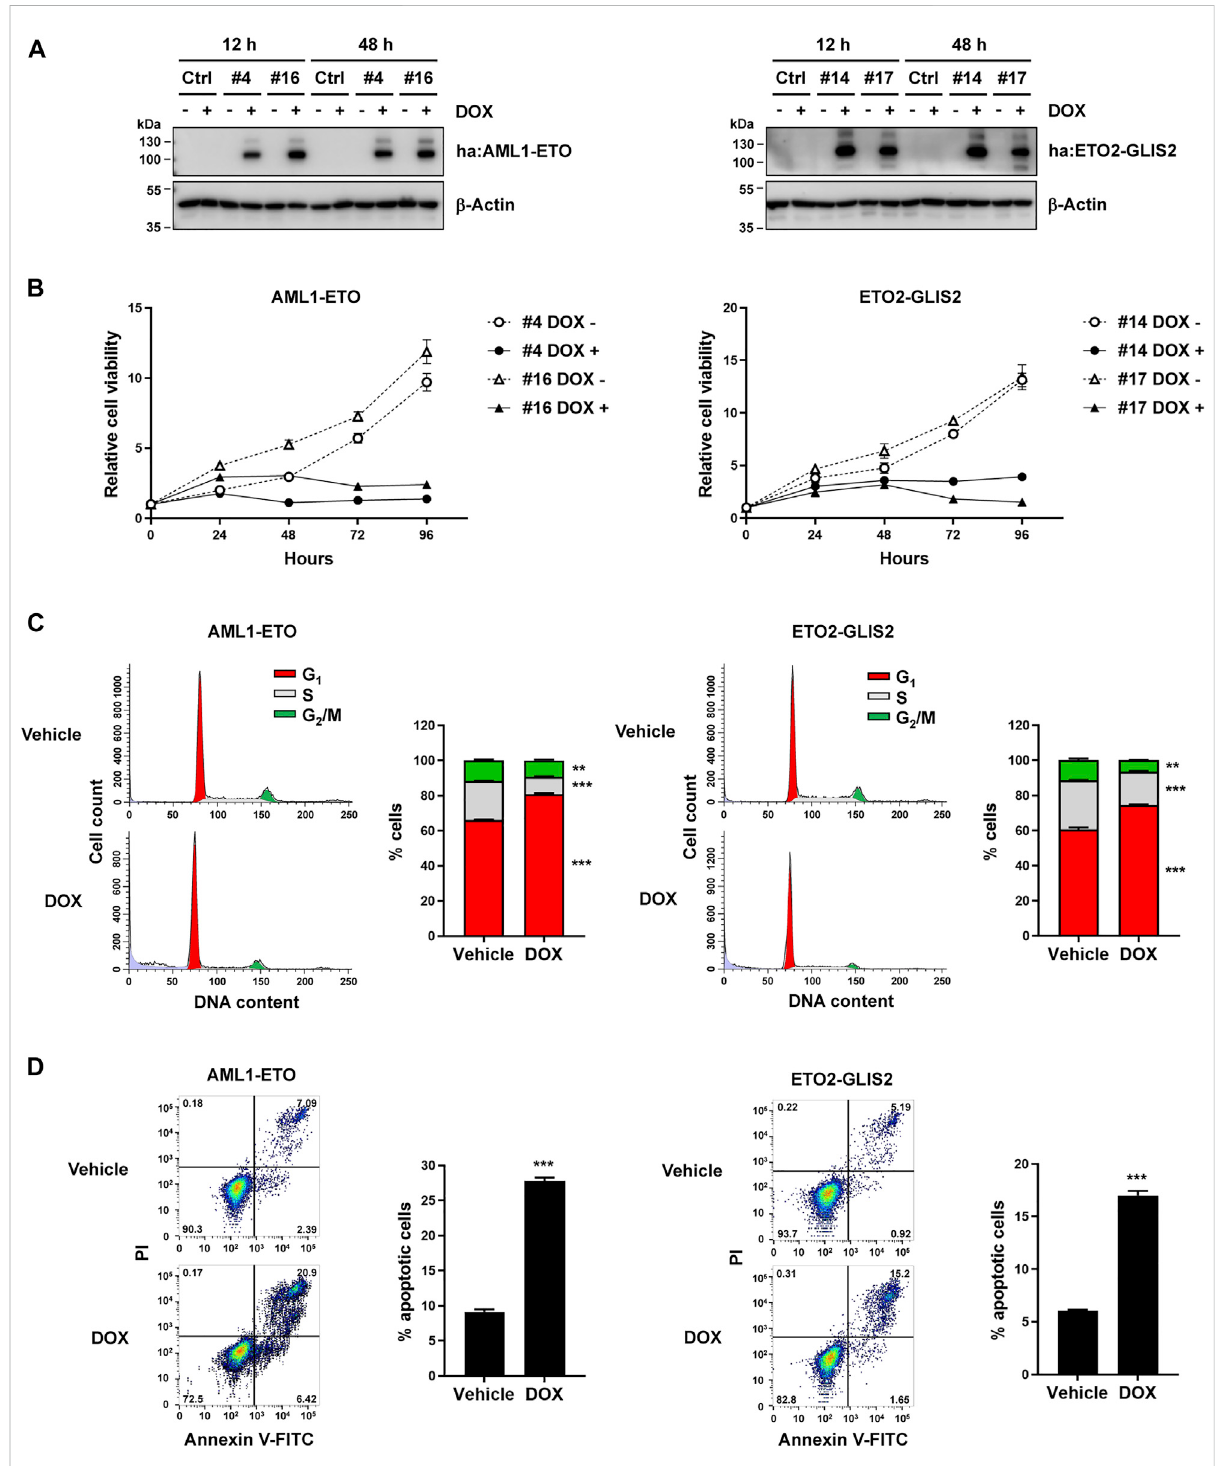
Establishmentofthecellularmodels — induced expressionofAML1-ETOand ETO2-GLIS2 inU937cells showed similarlyeffects on cellgrowth, cell cycle, and apoptosis. (A) Immunoblot analysis of four stable cell lines (i.e., # 4 and # 16 for AML1-ETO and # 14 and # 17 for ETO2-GLIS2), showing their expression of the HA-tagged (ha) AML1-ETO and ETO2-GLIS2 induced by doxycycline (DOX). The analysis was performed for each cell line at 12 and 48 h after induction. The fusion proteins were detected with an anti-HA antibody, and β -Actin was used as a loading control. (B) Cell viability analysis of the indicated stable cell lines with and without doxycycline induction. (C) Cell cycle analysis of AML1-ETO ( # 4) and ETO2-GLIS2 ( # 14)celllines withandwithoutdoxycycline induction.Eachrightpanel shows thequanti fi cationandstatisticalanalysis ofthecells inG 1 , S,and G 2 /M stages in percentage. (D) Flow cytometry analysis of apoptotic cells using propidium iodide (PI) and Annexin V. Each right panel shows the quanti fi cation and statistical analysis. In panels (B – D) , data are presented as means ± SD of three separate experiments; two-tailed t -test; *** p < 0.001; ** p <